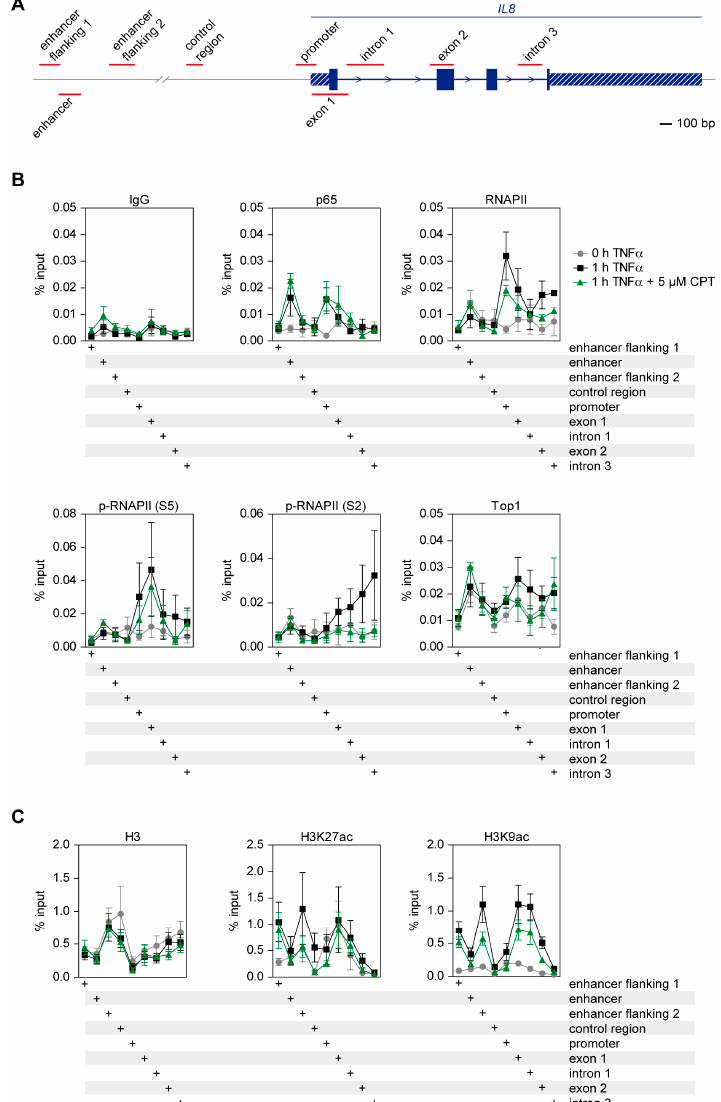
Figure 6. Effects of TOP1 inhibitors on transcription elongation, association of regulatory proteins and histone modifications. ( A ) Schematic display of the analyzed region covering parts of the IL8 locus. Exons are shown by the filled boxed areas, 3 ′ and 5 ′ UTR are indicated by shaded boxes and the positions of the regions detected by PCR are shown in red. ( B ) HCT116 cells were either treated for 2 h with 5 µM CPT and additionally for 1 h with TNF α or were treated for 0 or 1 h with TNF α alone. Cells were subsequently subjected to ChIP analysis using the indicated antibodies, chromatin binding of the various proteins was quantified via qPCR. Error bars show SEMs from three individual experiments. ( C ) The experiments were done as in ( B ) with the di ff erence that the levels of H3K27ac and H3K9ac-bound DNA were